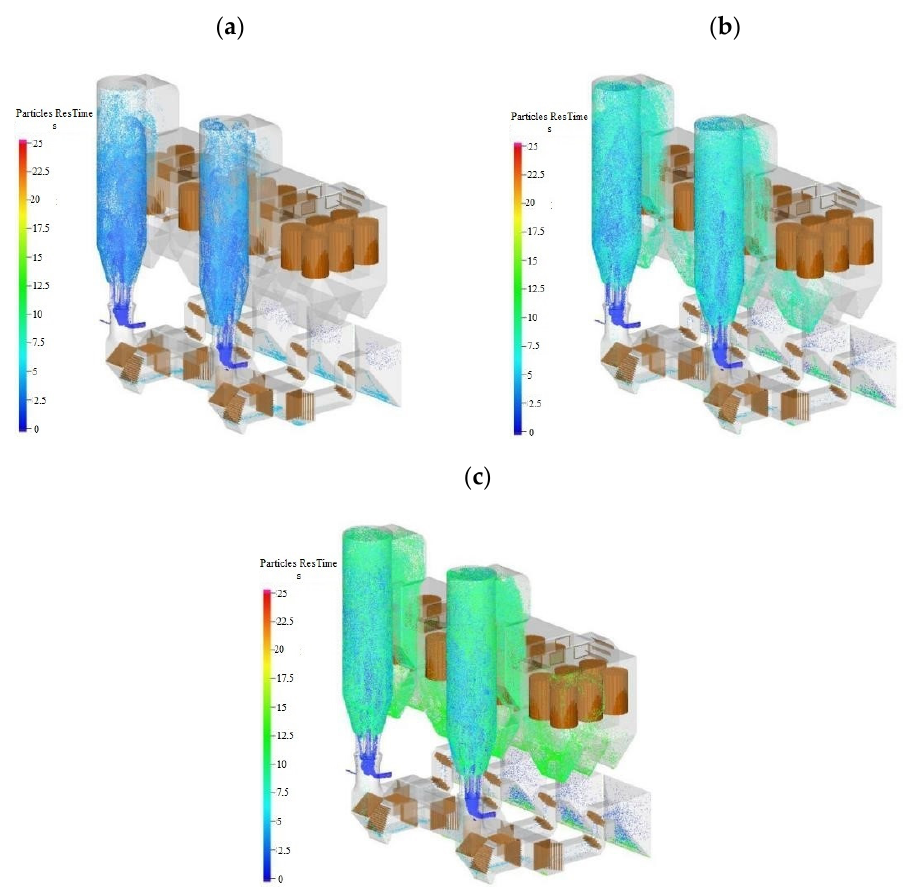
Figure 4. Particle distribution in the tower at different times. ( a ) t = 5 s ( b ) t = 10 s ( c ) t = 15 s.